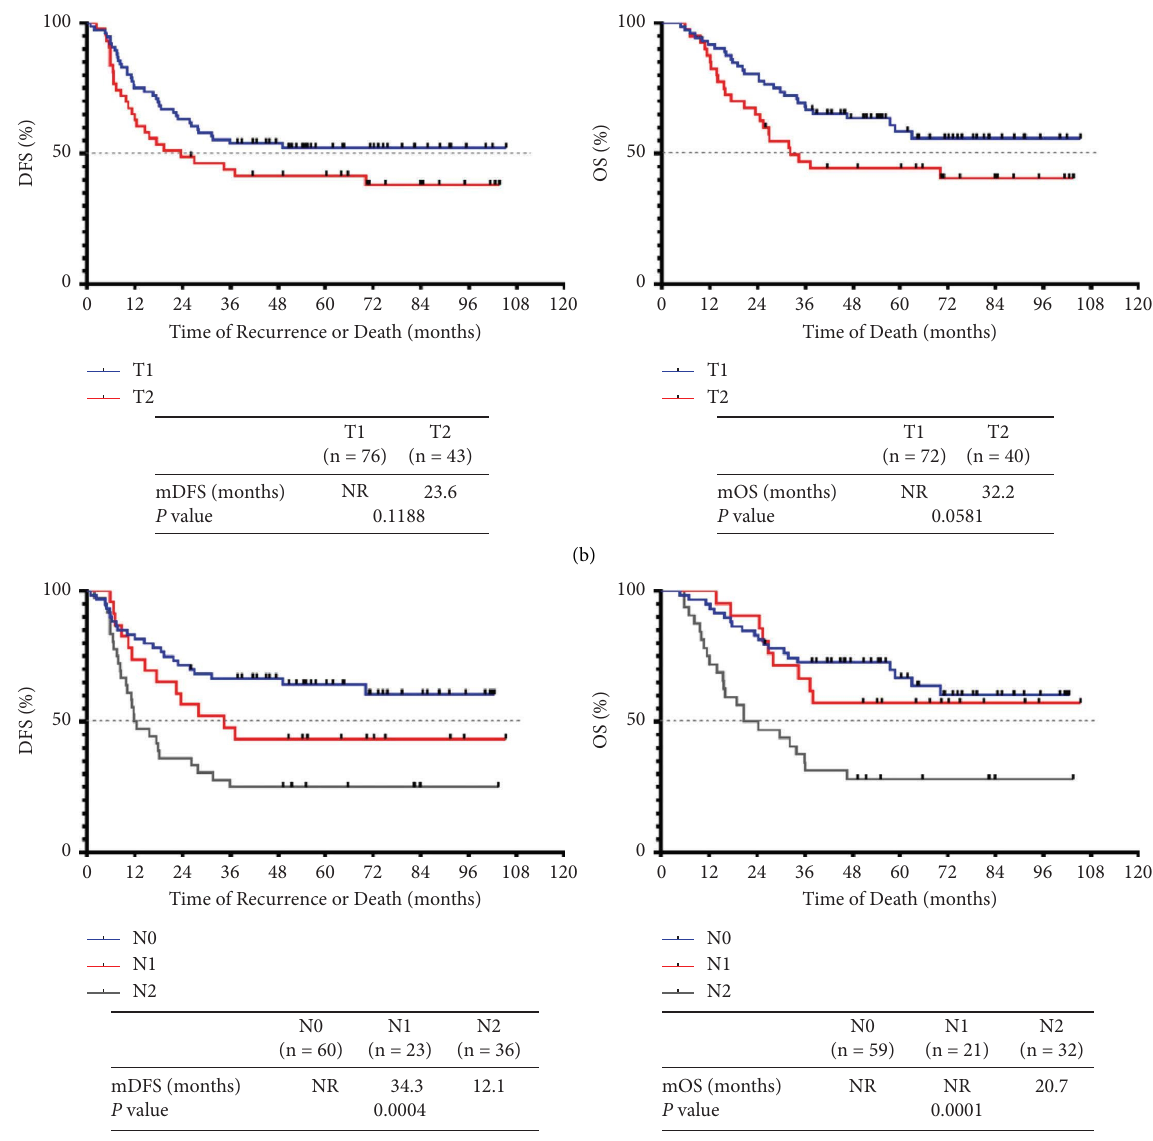
Figure 1: Identifcation and prognostic signifcance of TNM stage in LS SCLC-resected patients. (a) Te DFS ( n � 119) and OS ( n � 112) curves of LS SCLC-resected patients by TNM stage (I, II, and III). (b) Te DFS ( n � 119) and OS ( n � 112) curves of LS SCLC-resected patients by Tstage (T1 and T2). (c) Te DFS ( n � 119) and OS ( n � 112) curves of LS SCLC-resected patients by TNM stage (N0, N1, and